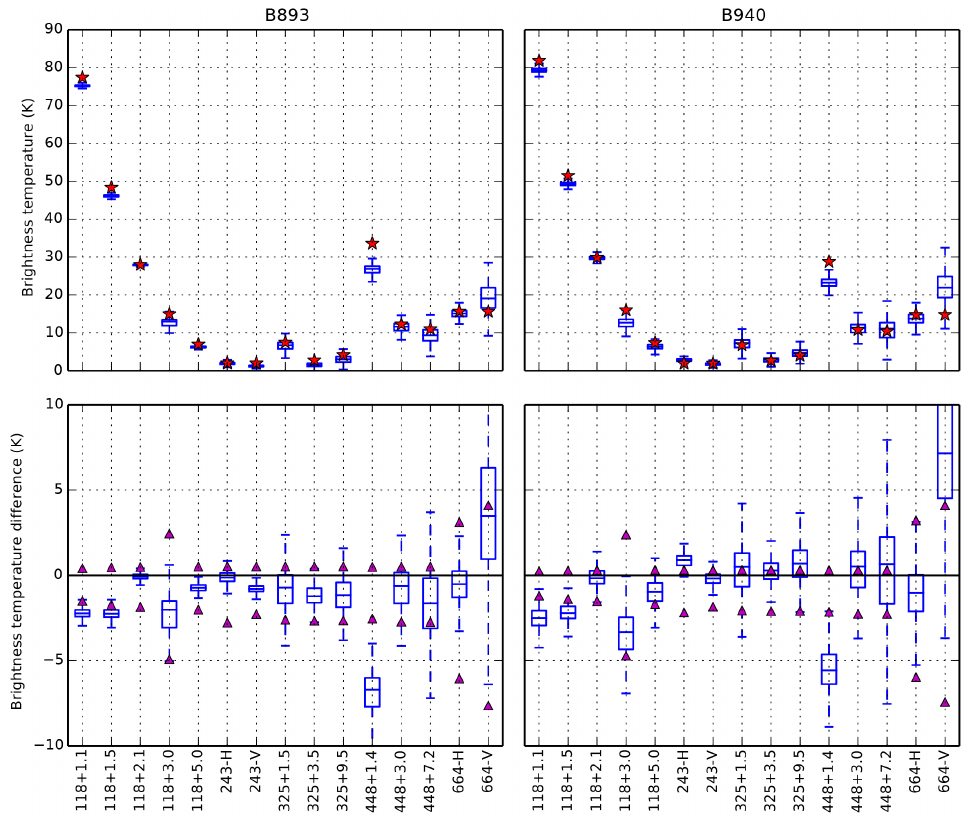
Figure 6. Top: zenith brightness temperatures during straight and level flight above the tropopause. The box and whiskers are the ISMAR measurements, and the stars are simulations. Bottom: difference between measurements and simulations. The triangles represent the esti- mated maximum bias in the